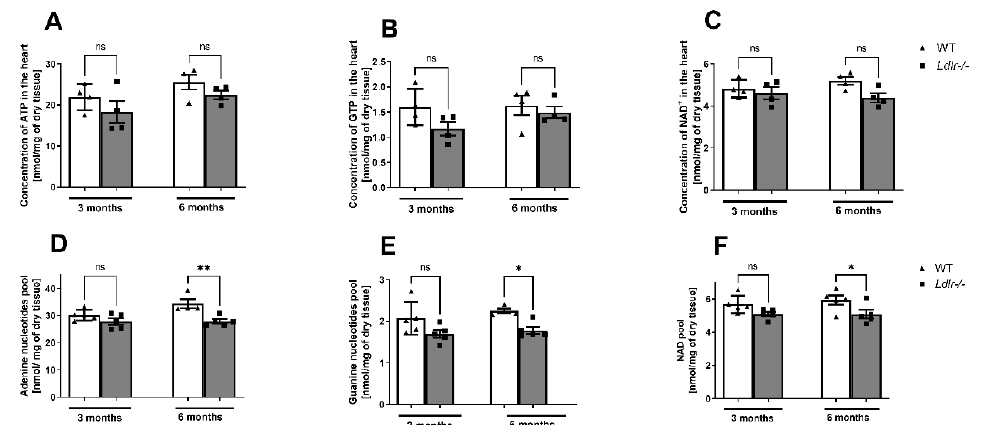
Figure 2. Diminished adenine and guanine nucleotides‘ pool in the hearts of dyslipidemic Ldlr − / − mice. The concentration of adenosine triphosphate (ATP) ( A ), guanosine triphosphate (GTP) ( B ), nicotinamide adenine dinucleotide (NAD + ) ( C ), and adenine ( D ), guanine ( E ), and NAD ( F ) pool in the heart of 3- and 6-month-old dyslipidemic ( Ldlr − / − ) and control (WT) mice, n = 4–5; * p < 0.05; ** p < 0.01; ns, non-significant.